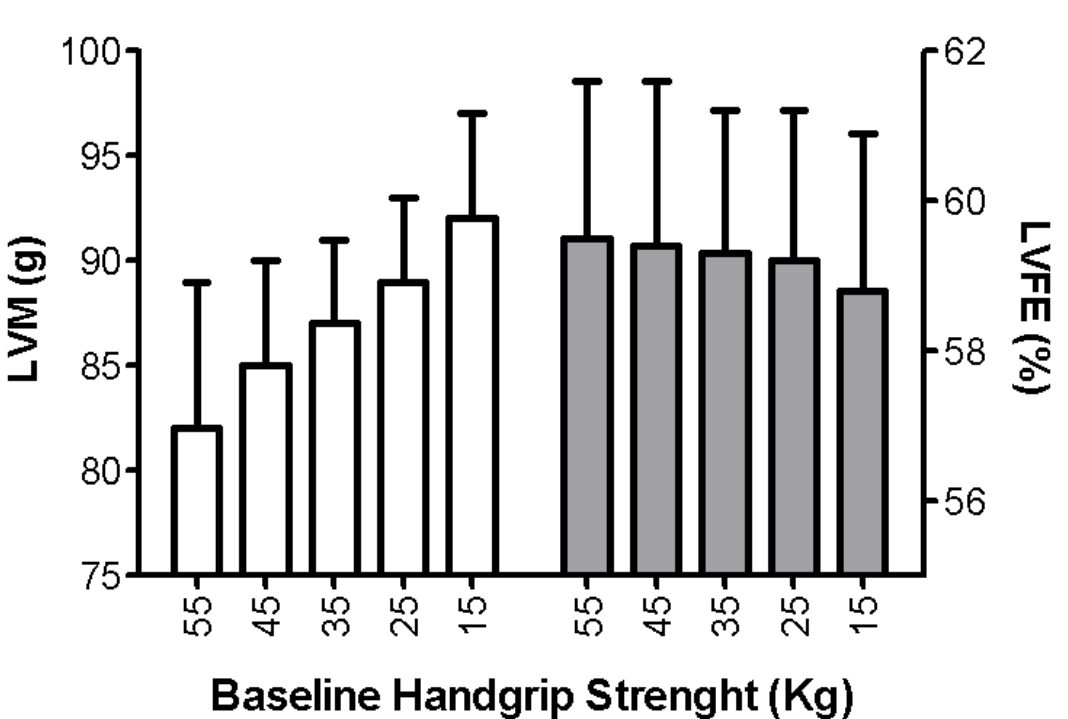
Figure 4. Increase of left ventricular mass [LVM, g] and reduction of left ventricular ejection fraction (LVEF, %) associated with a reduction of handgrip strength [modified by Beyer et al. [72]).